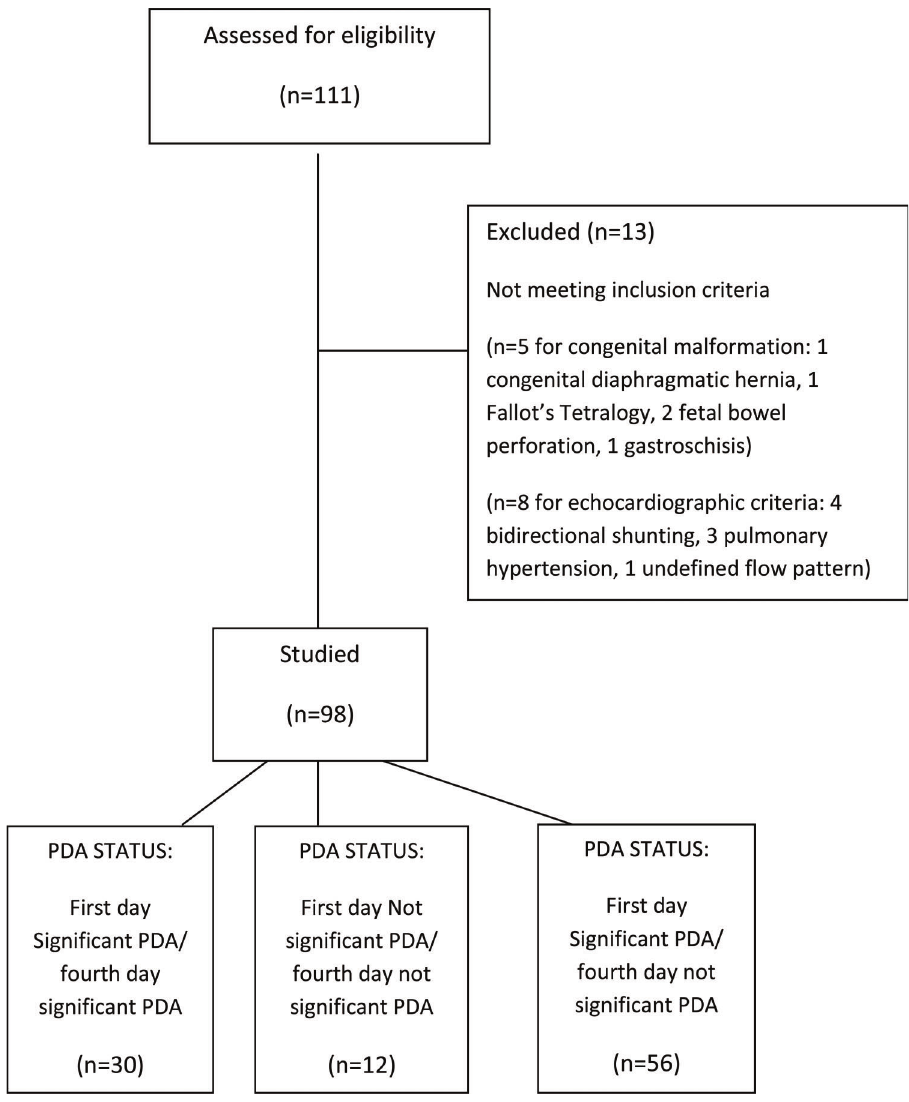
Figure 1 - CONSORT diagram showing the flow of participants through echocardiographic PDA evaluation.